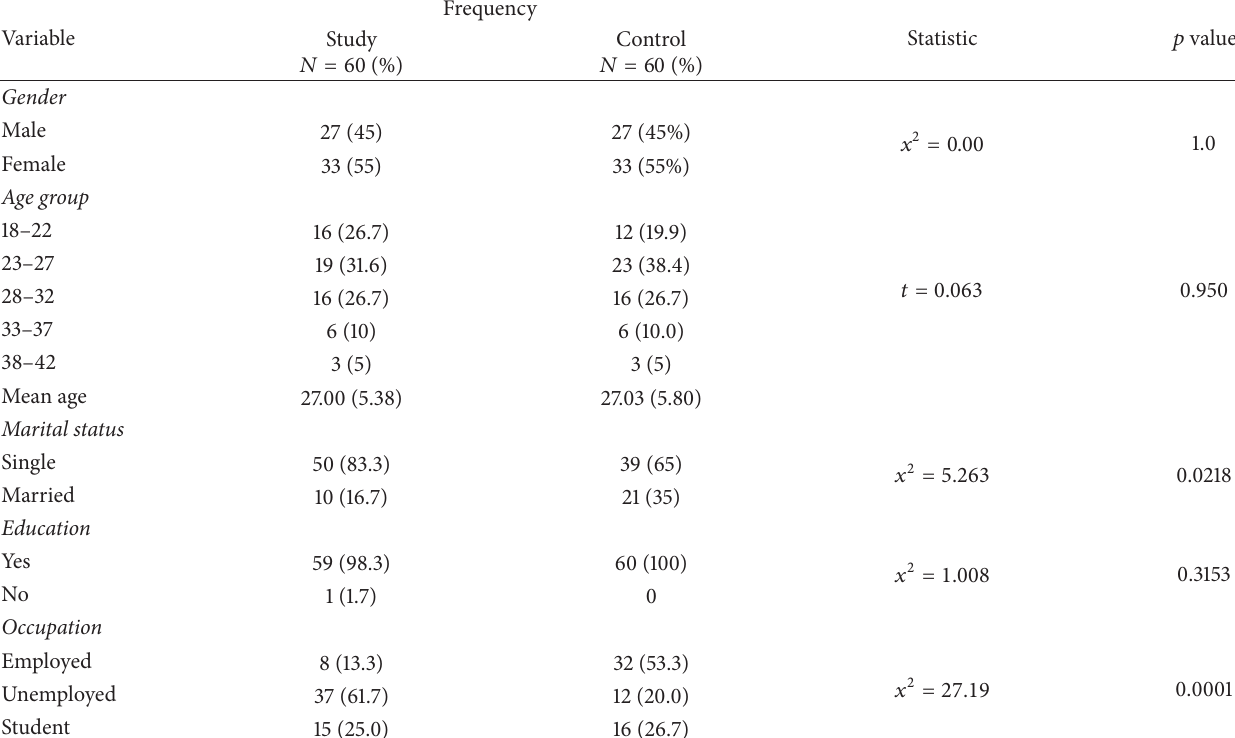
Table 1: Sociodemographic